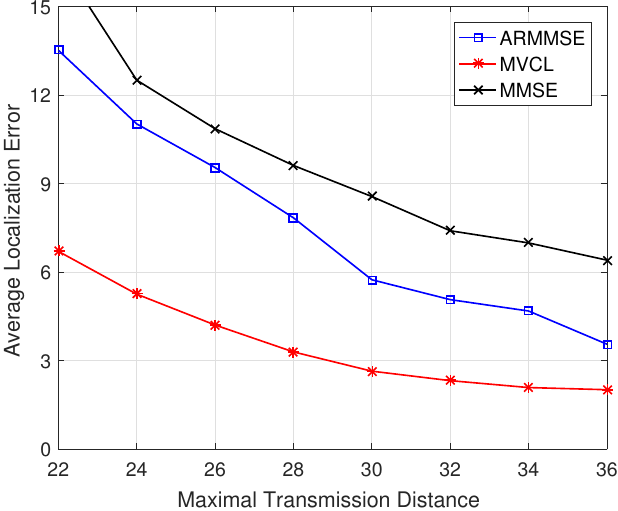
Figure 12. Average localization error with transmission range R ( n = 80, m = 20, k = 4, ζ = 15, η =